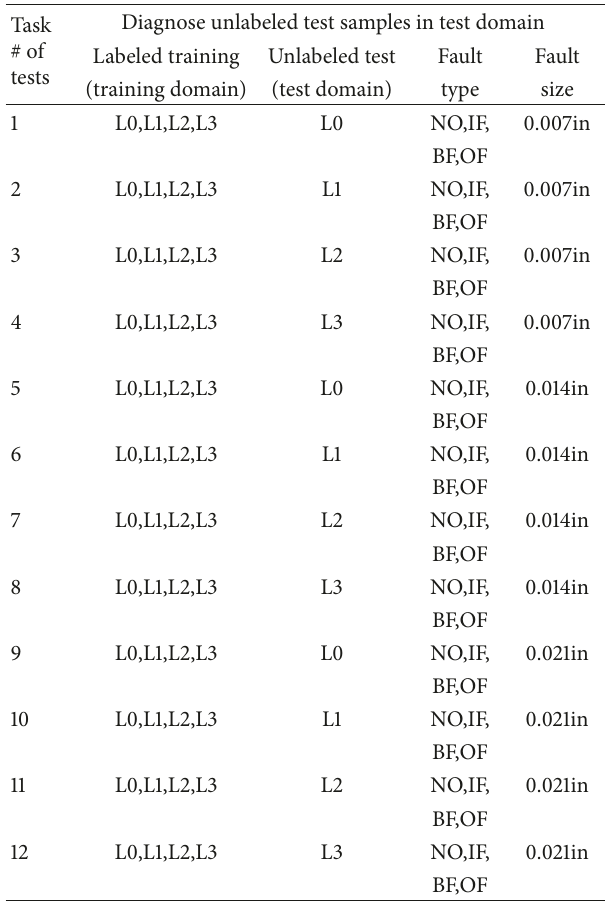
Table 1: Description of the experimental